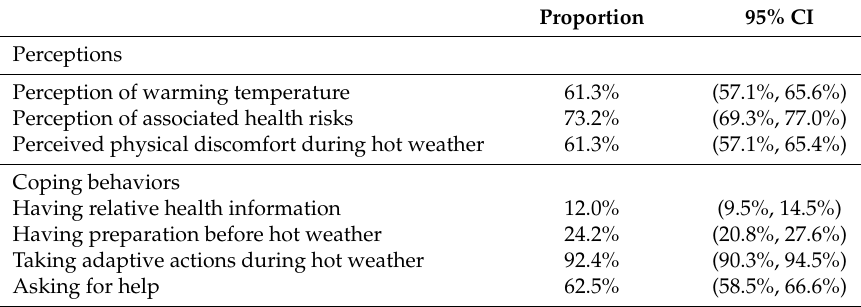
Table 2. Perceptions and coping behavior among the total study population.